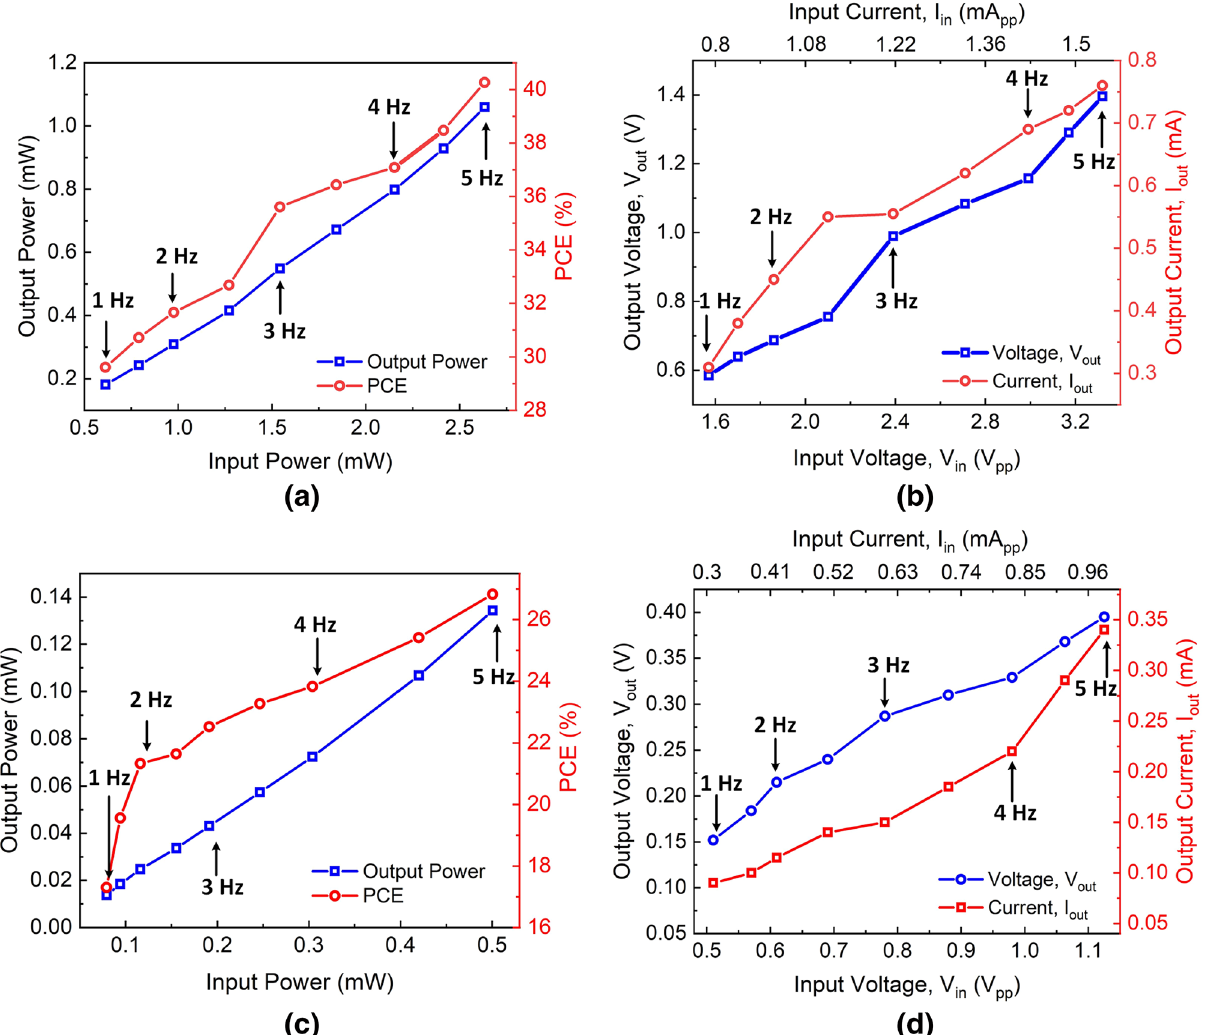
Figure 8. ( a ) Power output and power conversion efficiency, ( b ) output voltage and current for the energy harvested using 38 µ m porous diameter, ( c ) power output and power conversion efficiency, and ( d ) output voltage and current for the energy harvested using 100 µ m porous